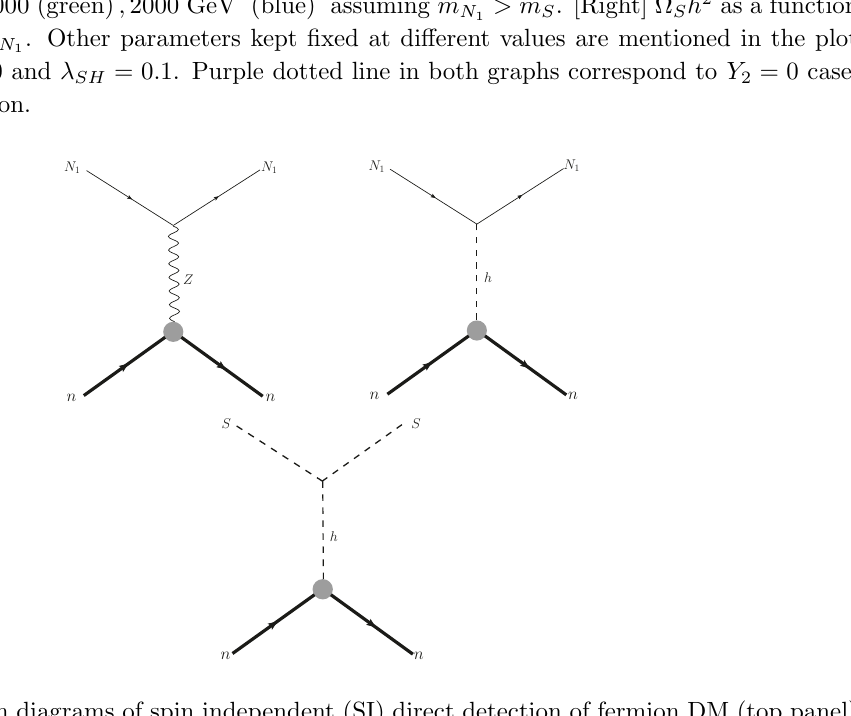
Figure 9 . Feynman diagrams of spin independent (SI) direct detection of fermion DM (top panel) and scalar DM (bottom